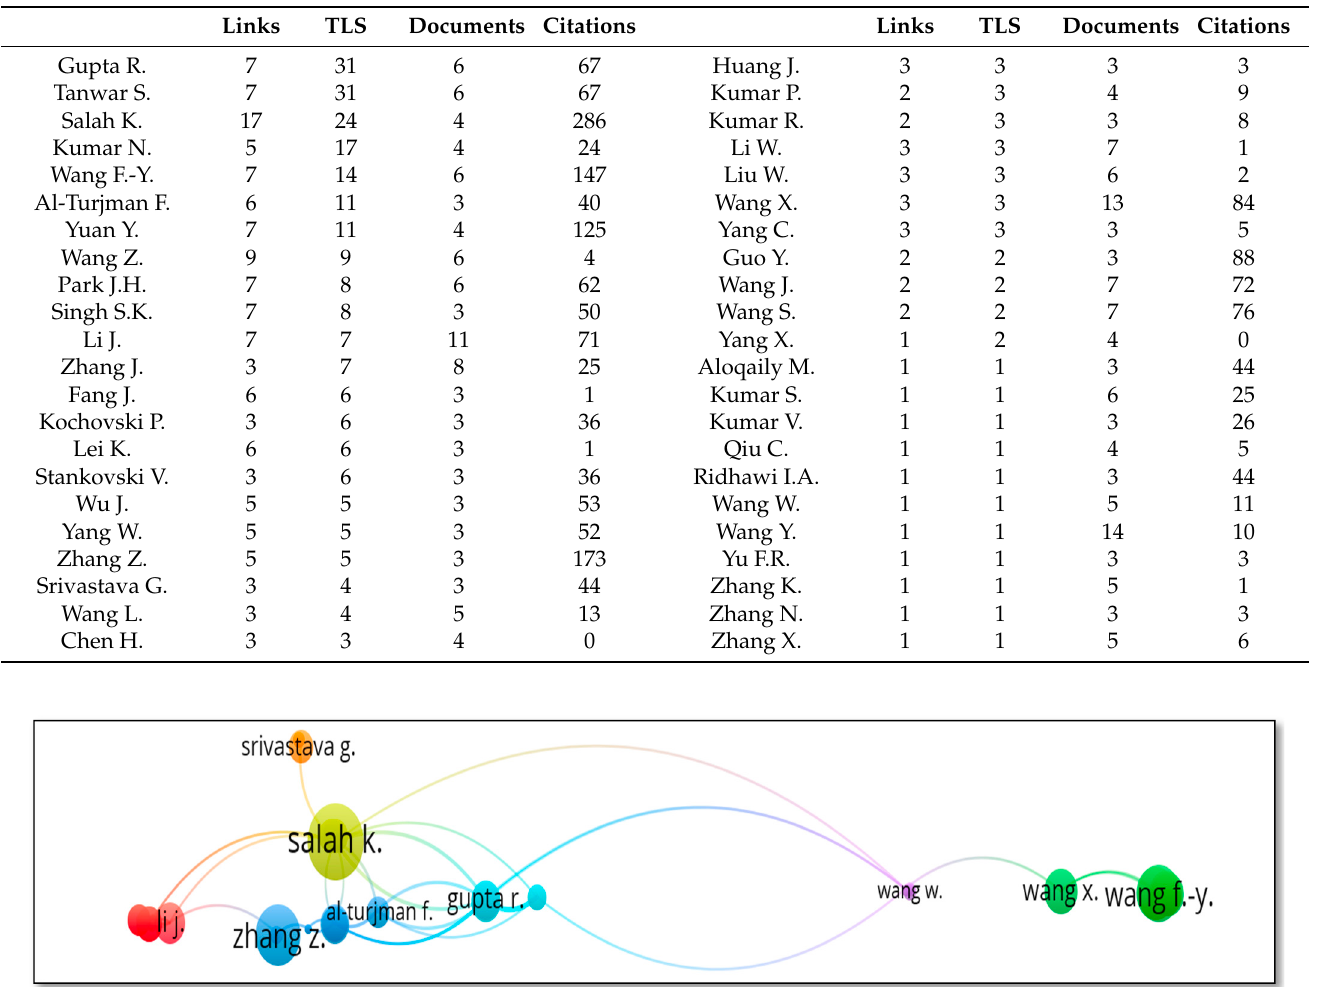
Figure 16. Citation analysis of authors.